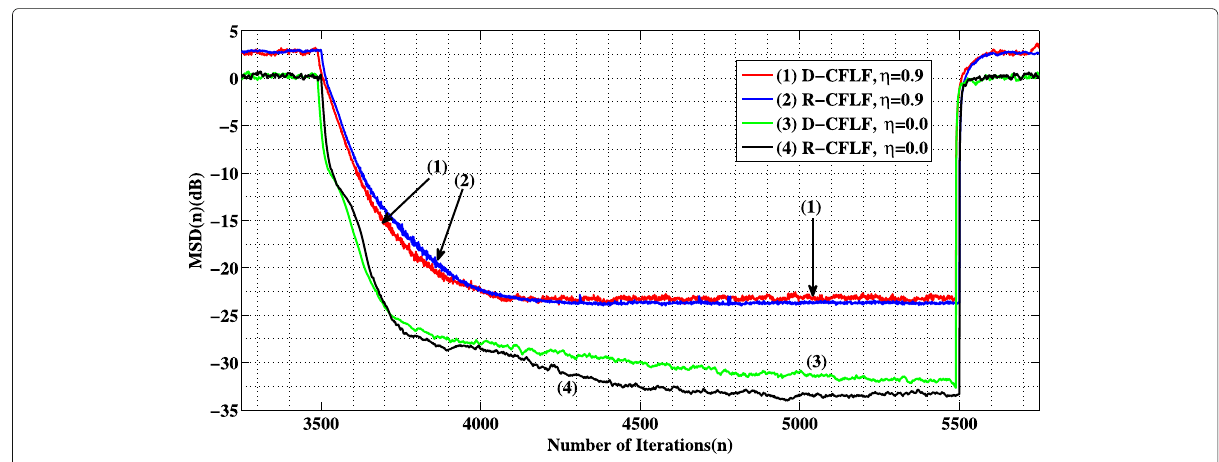
Fig. 22 Effect of coloring the input signal on the MSD performance of the proposed schemes